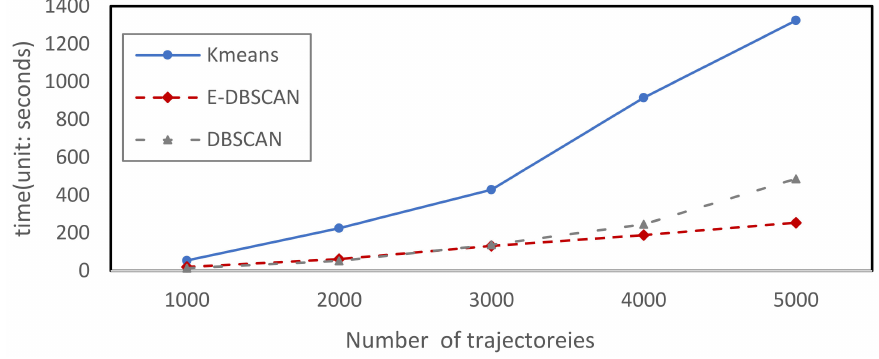
Figure 6. Efficiency